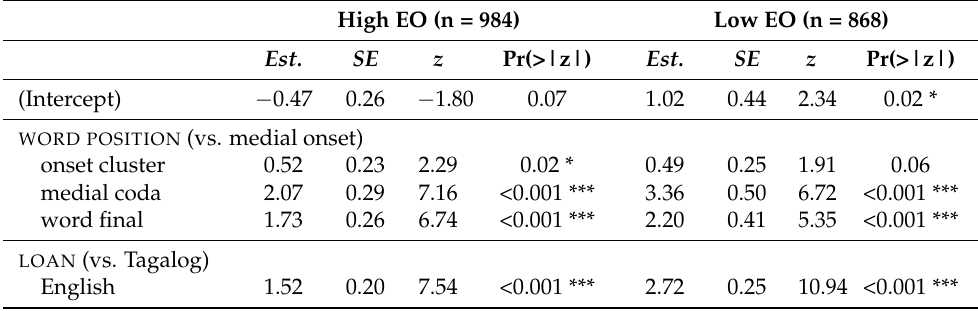
Table A4. Post-hoc analysis for EO - LG (language use/preferences) comparison, evaluating the effect of WORD POSITION and LOAN for High EO (Tagalog-oriented) and Low EO (English-oriented) speakers separately. Significance codes: <0.001 ‘***’; <0.05